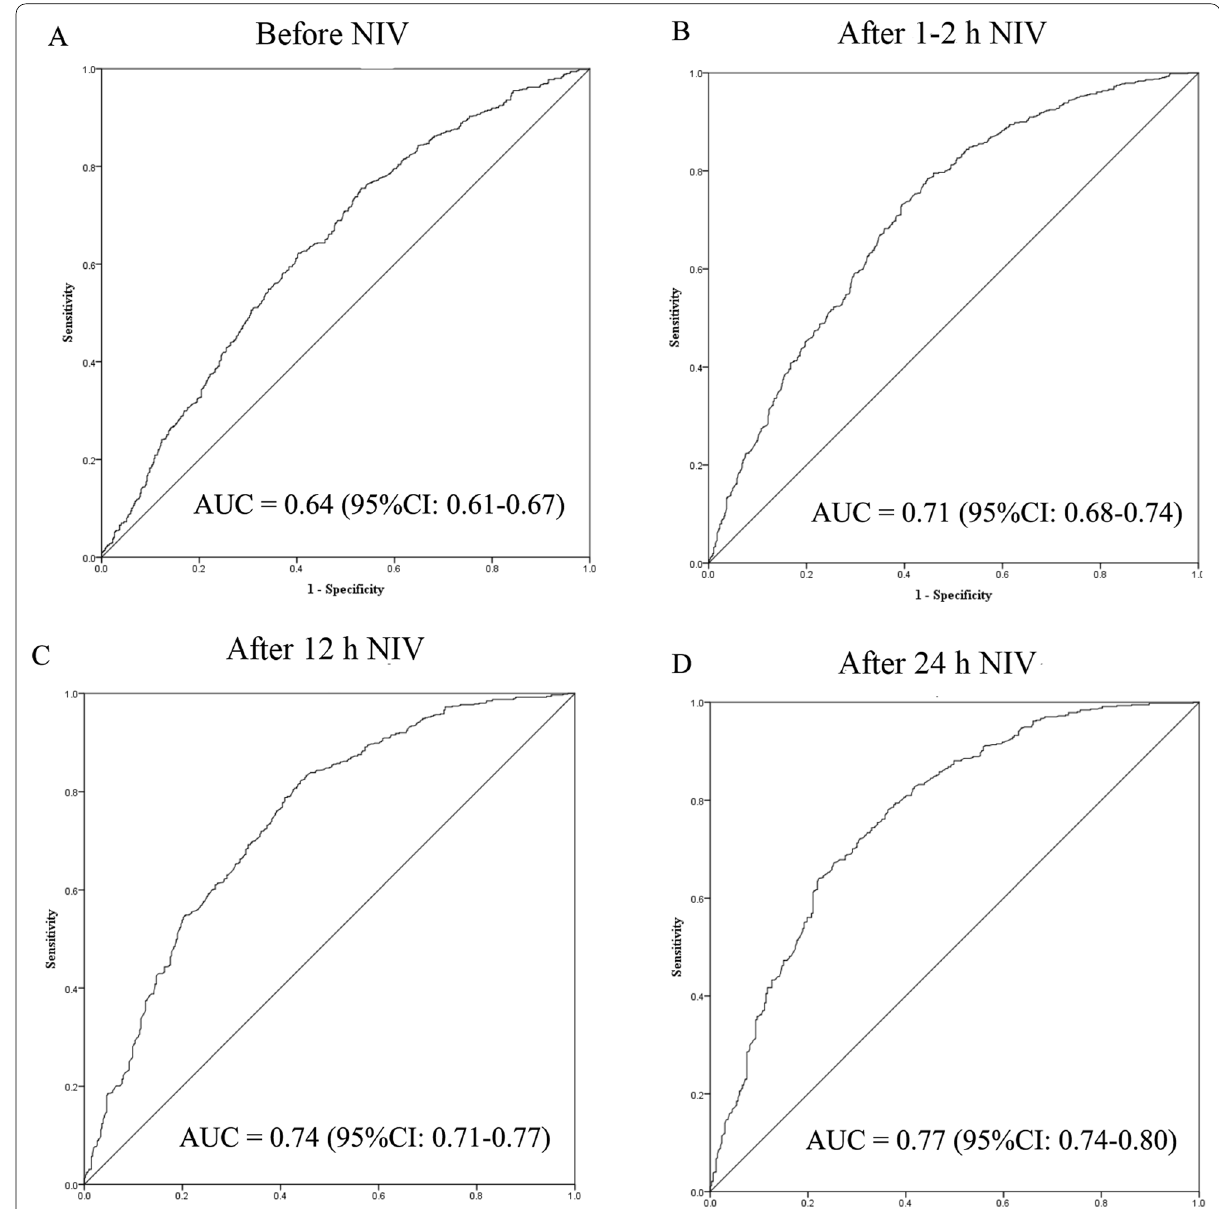
Fig. 4 Predictive power of NIV failure tested by ROX index. ROX SpO 2 /FiO 2 to respiratory rate, AUC area under the receiver operating characteristics curve, NIV noninvasive ventilation, CI confidence